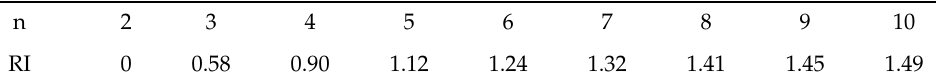
Table 2. Random index for different values of n